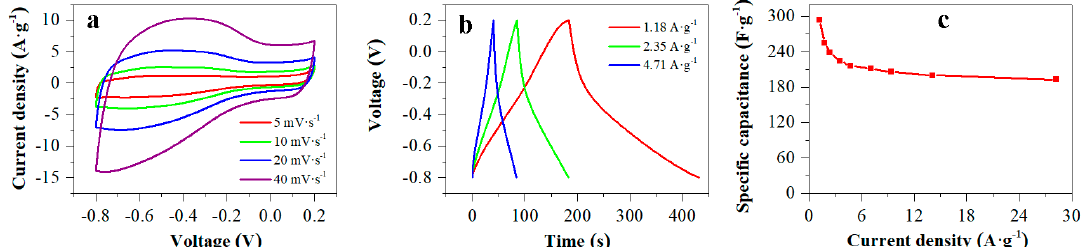
Figure 4. CV plots at various scan rates ( a ), GCD curves at different charging/discharging current densities ( b ) and specific capacitances versus current densities ( c ) for a GHE1-based supercapacitor. Table 1. Comparison of the gravimetric capacitance for GH ‐ based electrodes on different current collectors.